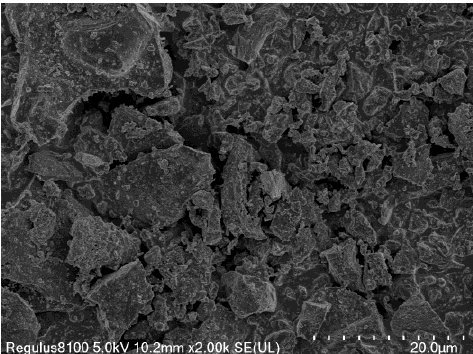
Figure 1. Micro-morphology diagram of ferrochrome slag powder.